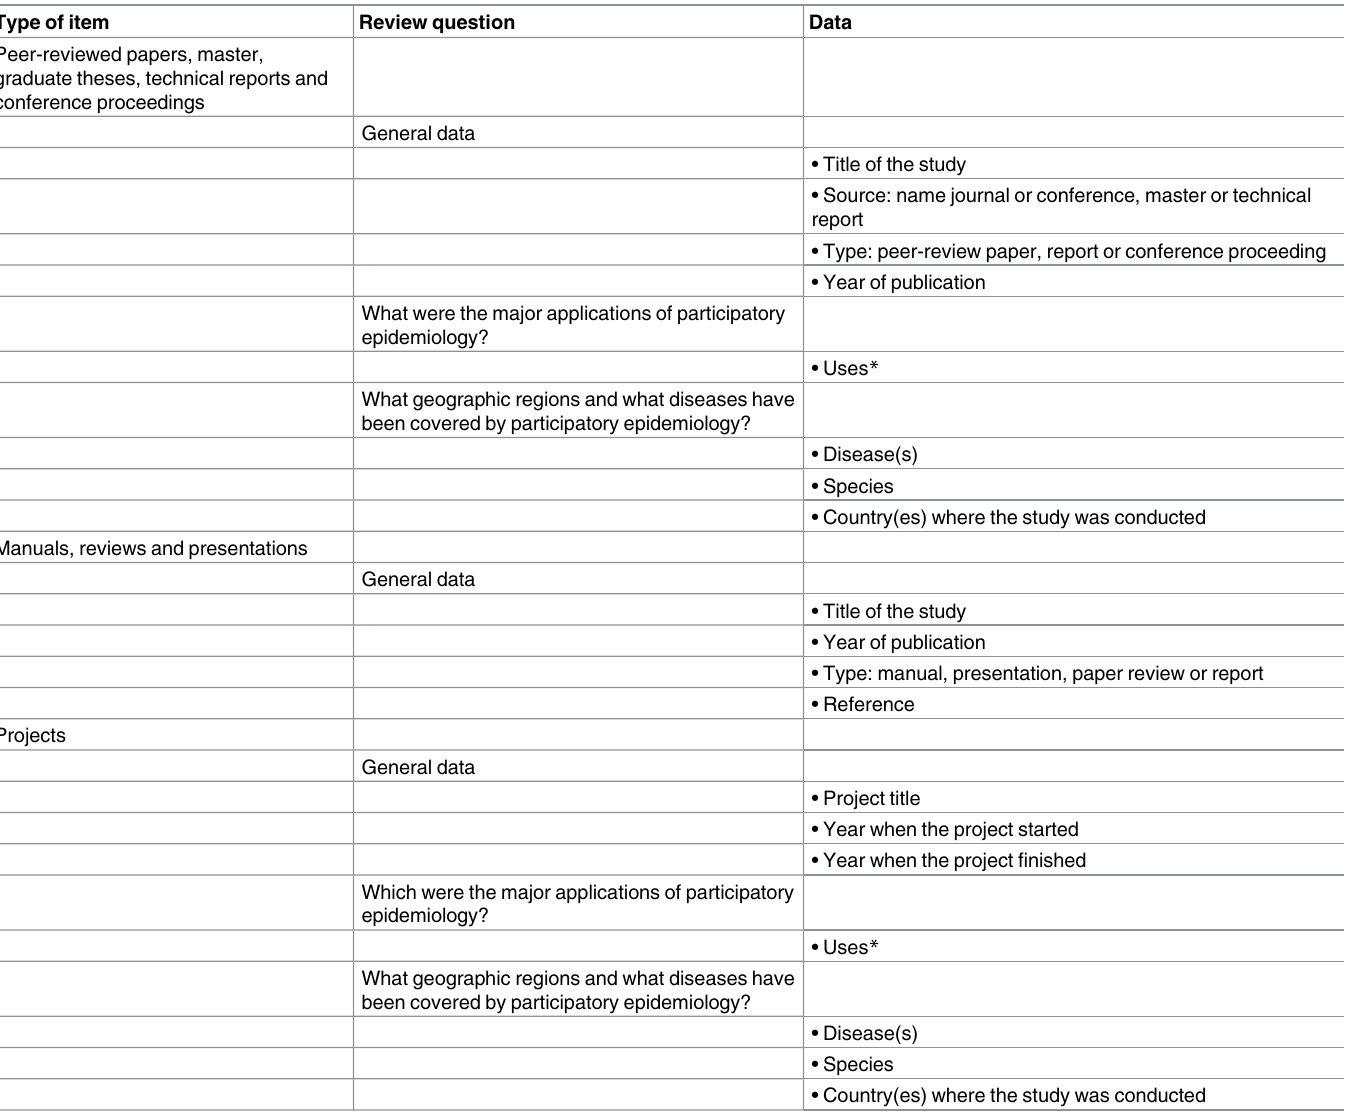
Table 1. Data fields extractedfrom the different